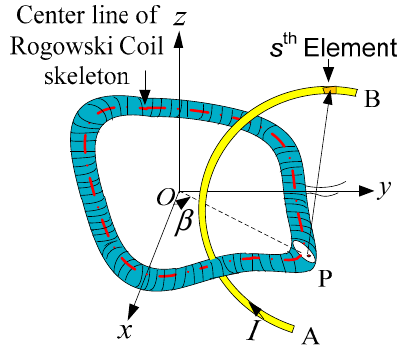
Figure 4. Structure diagram of a Rogowski coil and a finite-length curvilinear conductor.